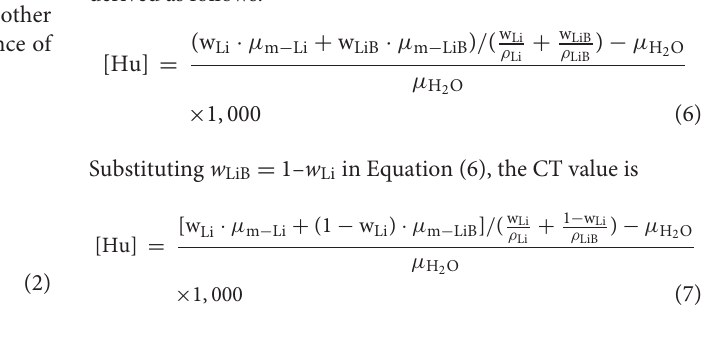
Figure 4b , the CT image of the axial section reveals that there is a big difference in the actual X-ray absorption capacity of the material in the different regions as evidenced by the different colors. The different colors represent the wide variation in CT values, reflecting the changes of density. The closer the color is to red, the larger the CT value and the higher the density, reflecting the presence of more framework phase components (LiB and LiBC). The closer the color is to purple, the smaller the CT value and the lower the density, reflecting the presence of more matrix components (Li-Mg SS). Thus, CT scanning provides a powerful means to measure and image the uneven spatial distribution of the components, which may reflect uneven shrinkage during ingot preparation and differences in the elemental composition and the porosity. Further commentary on these differences will be elaborated